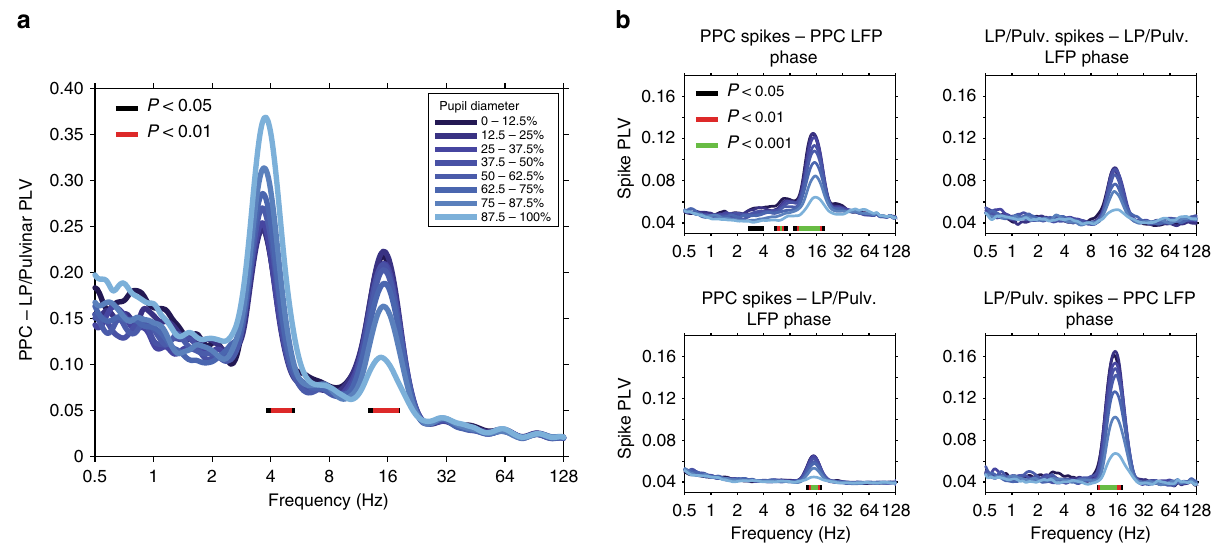
Fig. 3 Thalamo-cortical synchronization varies with ongoing fl uctuations in pupil-linked arousal. a PLV measured between LP/Pulvinar and PPC as a function of LFP frequency and pupil diameter. Pupil diameter is denoted by color (see legend). Note the prominent thalamo-cortical phase synchronization in the theta ( ∼ 4 Hz) and alpha (12 – 17 Hz) carrier frequency bands. Signi fi cant modulation across pupil diameter bins is indicated by bars plotted below PLV traces (one-way ANOVA, FDR-corrected P -values). PLV in the theta band signi fi cantly increased with pupil dilation, while alpha PLV signi fi cantly decreased with pupil dilation. b The phase synchronization (PLV) of spiking activity to LFP rhythms recorded within the same brain structure (top row), as well as between regions (bottom row). Spike PLV both locally within PPC and LP/Pulvinar, as well as between PPC and LP/Pulvinar revealed phase locking of spiking activity to alpha oscillations. Signi fi cant modulation of spike PLV across pupil diameter bins is indicated by color bars plotted below PLV traces (one-way ANOVA, FDR-corrected P -values). Note that the strongest alpha band spike PLV was observed between LP/pulvinar spikes and PPC LFP population, PPC: P = 0.003, one-way ANOVA, r = 0.30; LP/Pulvinar: P = 9.56 × 10e − 11 , r = 0.55). Multi-unit spiking